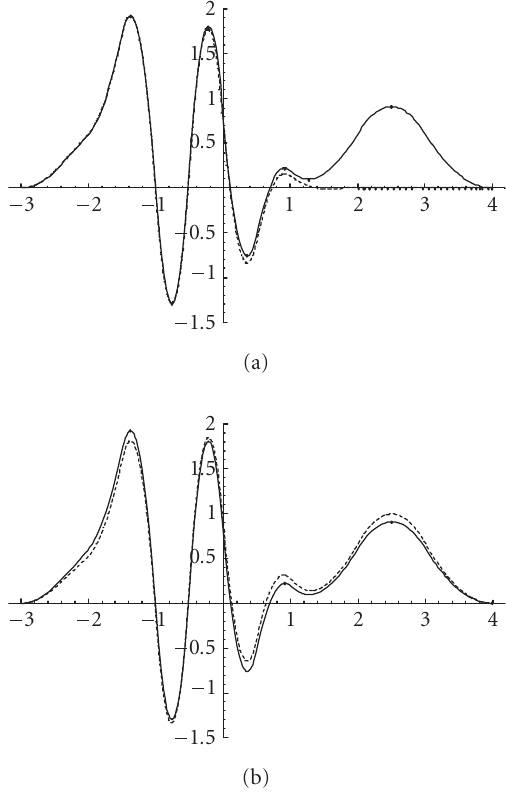
Figure 1. Drop two basis functions: iteratively (a), and simultaneously (b), for Example